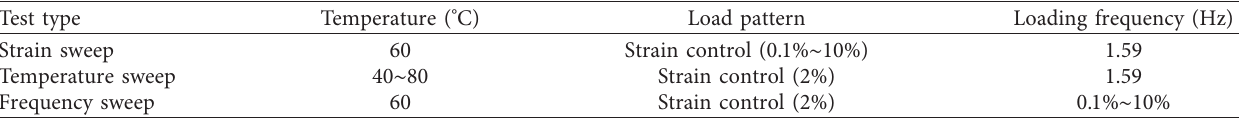
Table 6: Settings of the